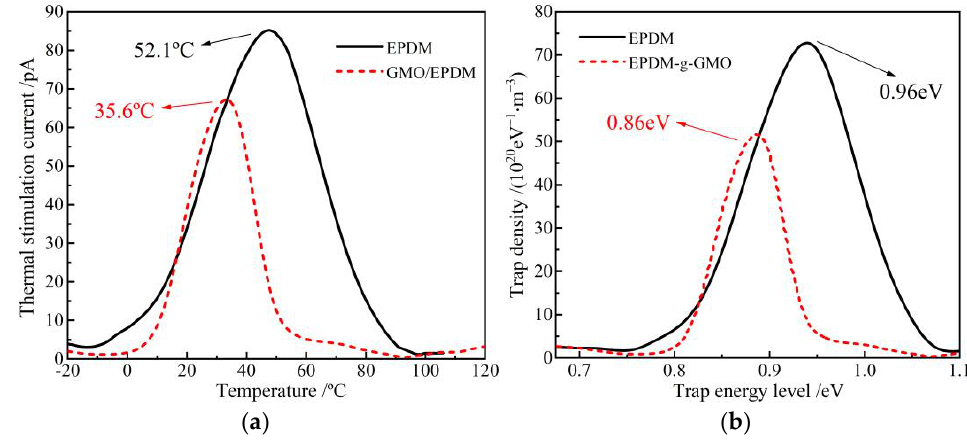
Figure 7. ( a ) TSC temperature spectra and ( b ) trap characteristics of EPDM and EPDM-g-GMO.